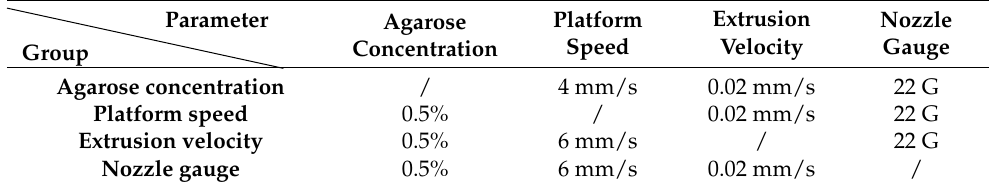
Table 1. Values of the parameters in the extrusion experiments. Extrusion Platform Nozzle Parameter Agarose Velocity Speed Gauge Concentration Group Agarose concentration / 4 mm/s 0.02 mm/s 22 G Platform speed 0.5% / 0.02 mm/s 22 G Extrusion velocity 0.5% 6 mm/s Nozzle